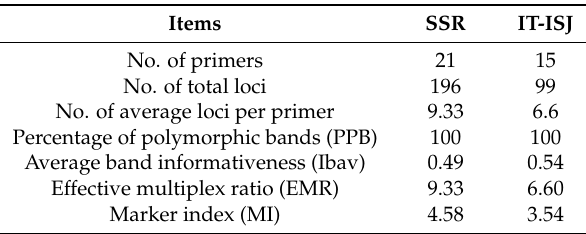
Table 2. Efficiency parameters of SSR and IT-ISJ markers. Items SSR